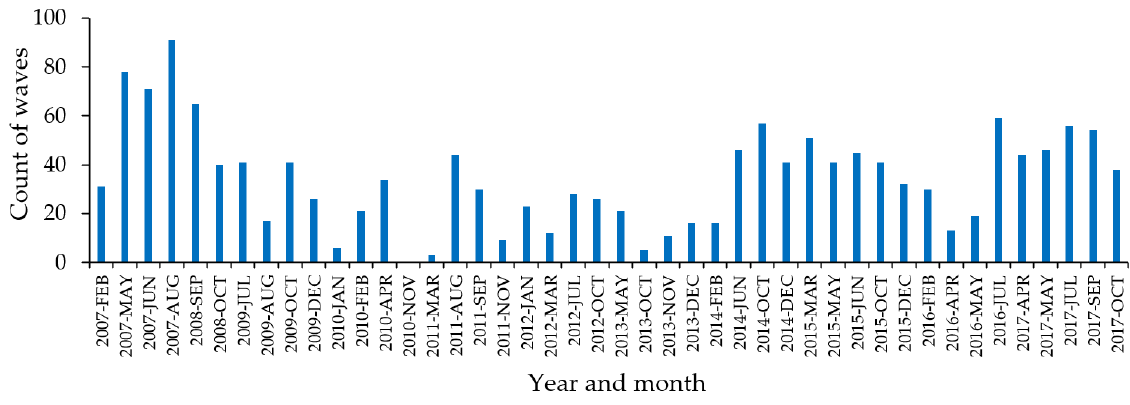
Figure 6. Count of “evil waves” in the selected month in period